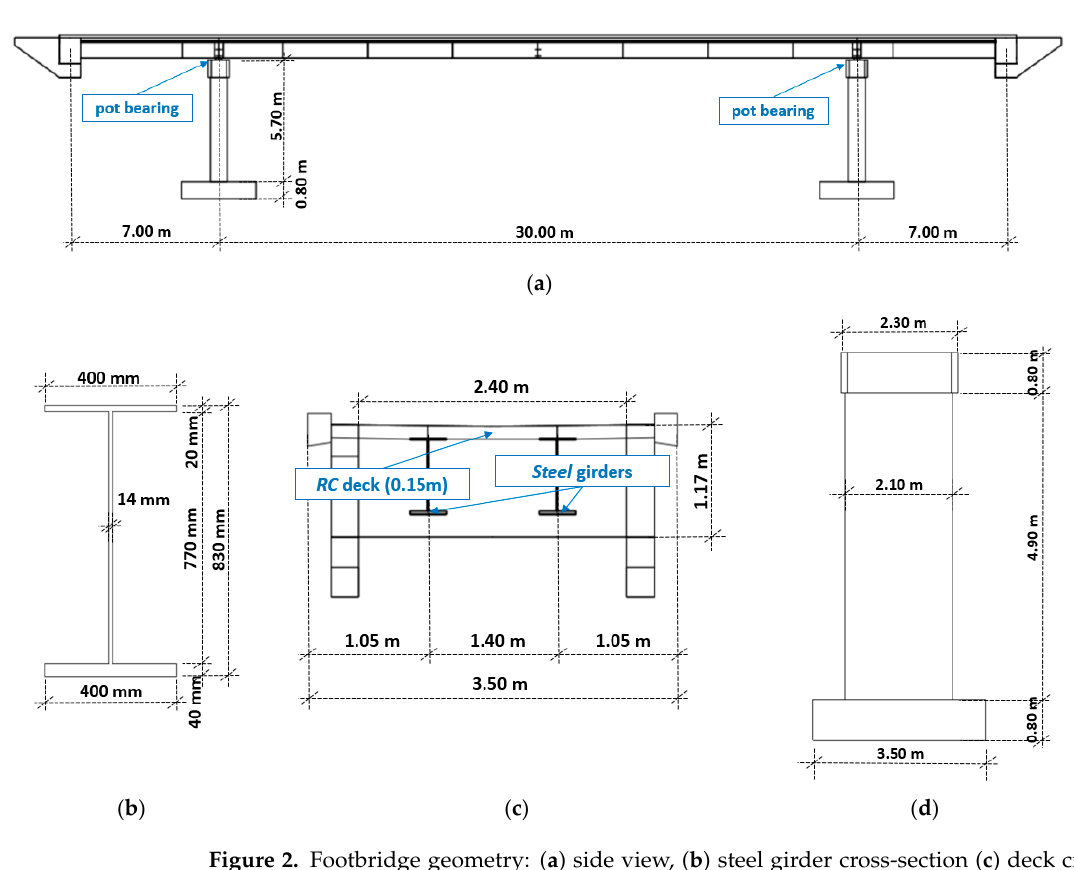
Figure 2. Footbridge geometry: ( a ) side view, ( b ) steel girder cross-section ( c ) deck cross-section ( d ) pier section. Table 1. Material parameters and element masses of the footbridge.